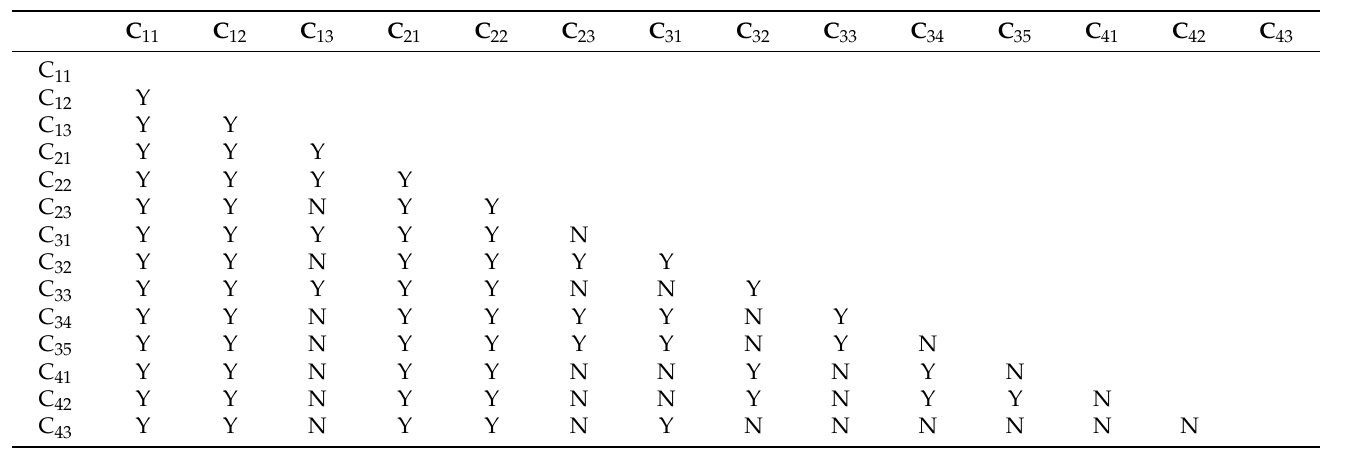
Table 9. Statistical significance of the influences of pairwise factors on tea cultivation suitability assessment (95% confidence level).